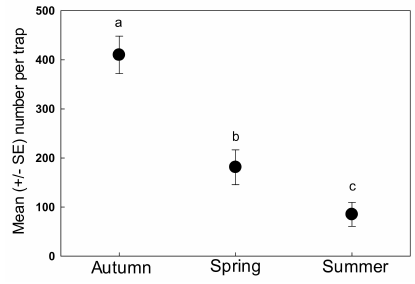
Figure 2. Seasonal abundance of all arthropods associated with A. tridentata in the Yakima Valley, Washington. Different letters denote significant differences ( p < 0.001).